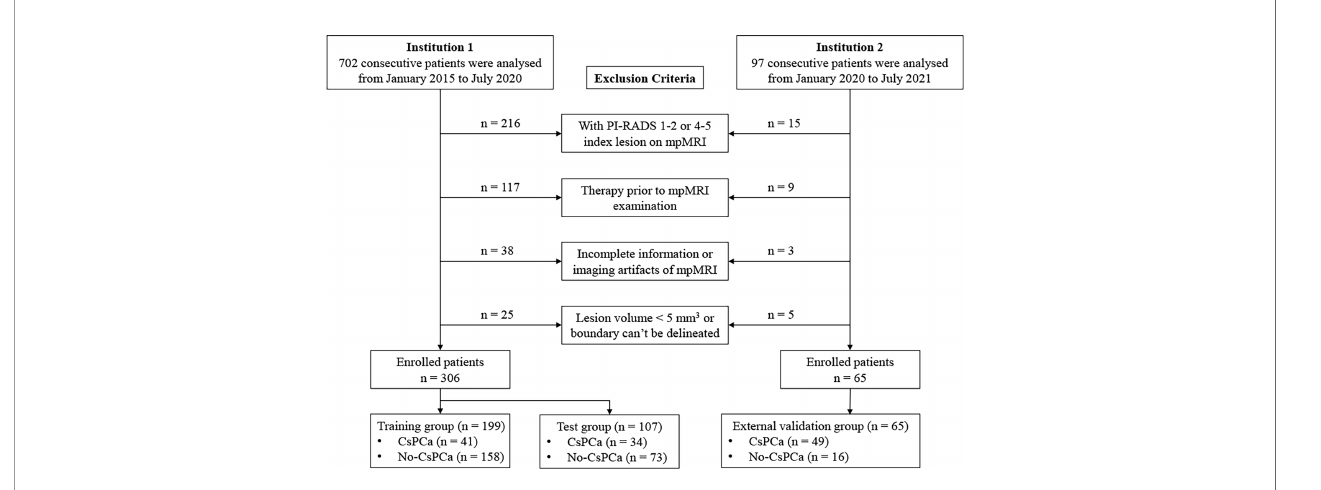
FIGURE 1 | The fl owchart of patient